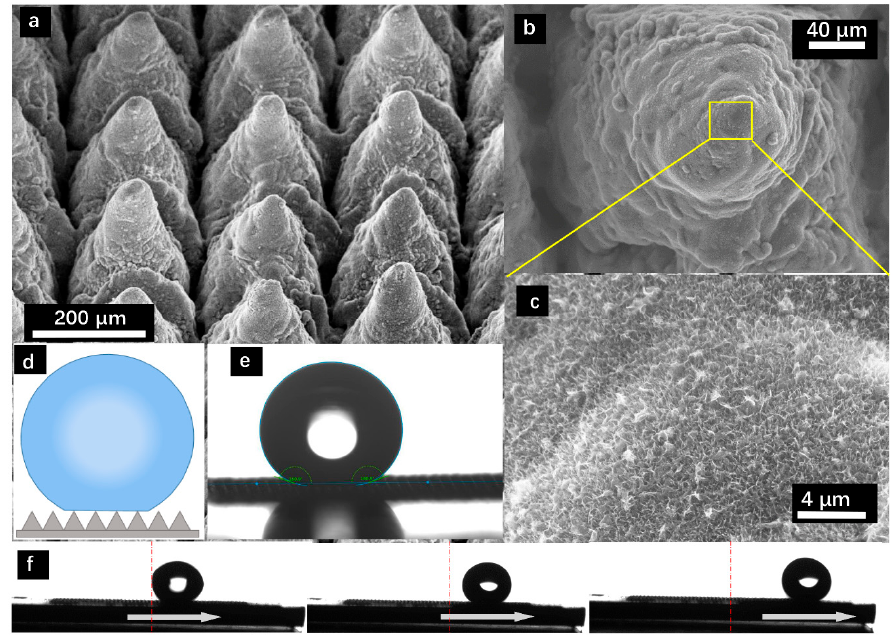
Figure 2. Scanning electron microscopy (SEM) images of the as-prepared surface with different magnifications: ( a ) 100x; ( b ) 500x; ( c ) 5000x; ( d ) Cassie–Baxter state; ( e ) Optical micrograph of water droplets; ( f ) Water droplets slide off the surface. Hydrothermal temperature is 150 °C.